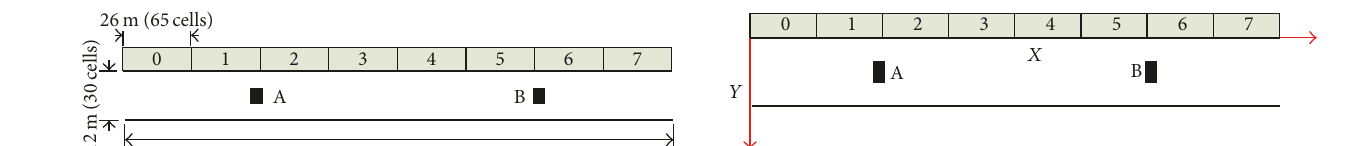
Figure 4: The simplified sketch of the HRS platform.